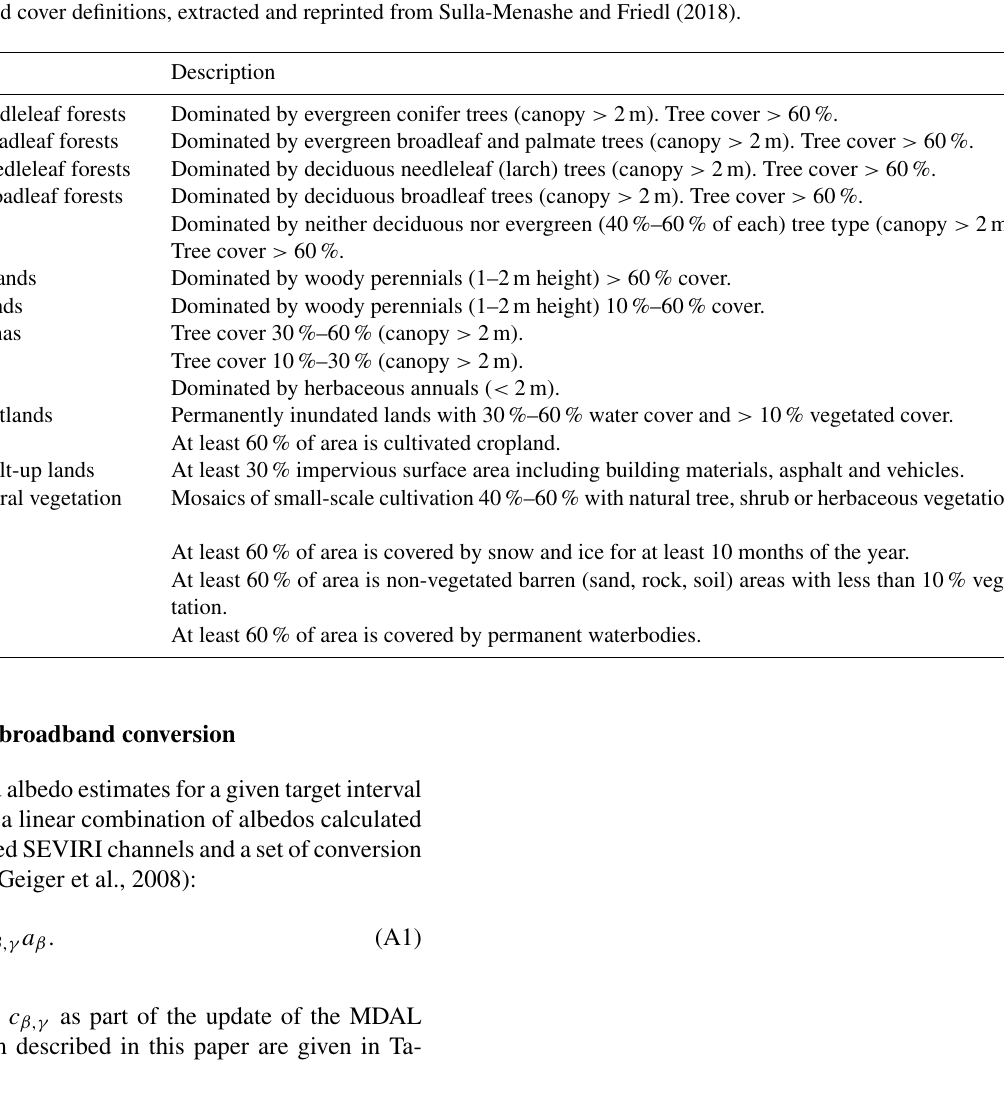
Table A2. Narrow- to broadband conversion coefficients used for MDAL albedo retrieval, before and after update. New values in bold. Bandwidth interval